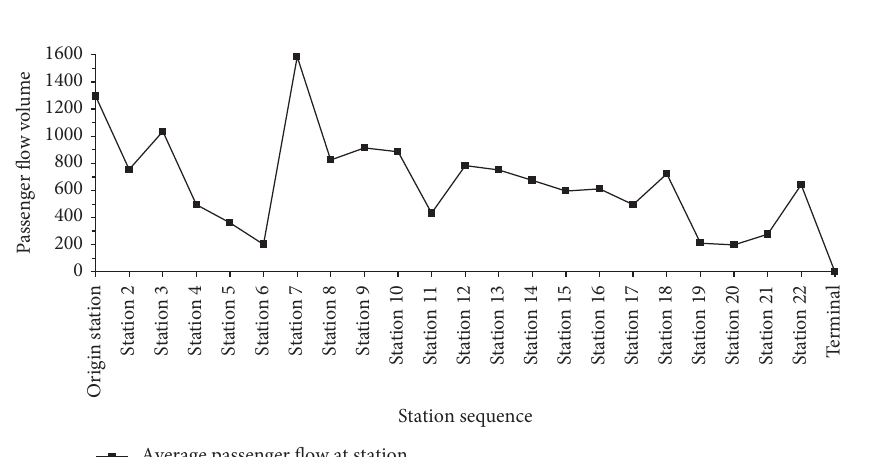
Figure 1: Daily average passenger flow at all stations of bus line 28.